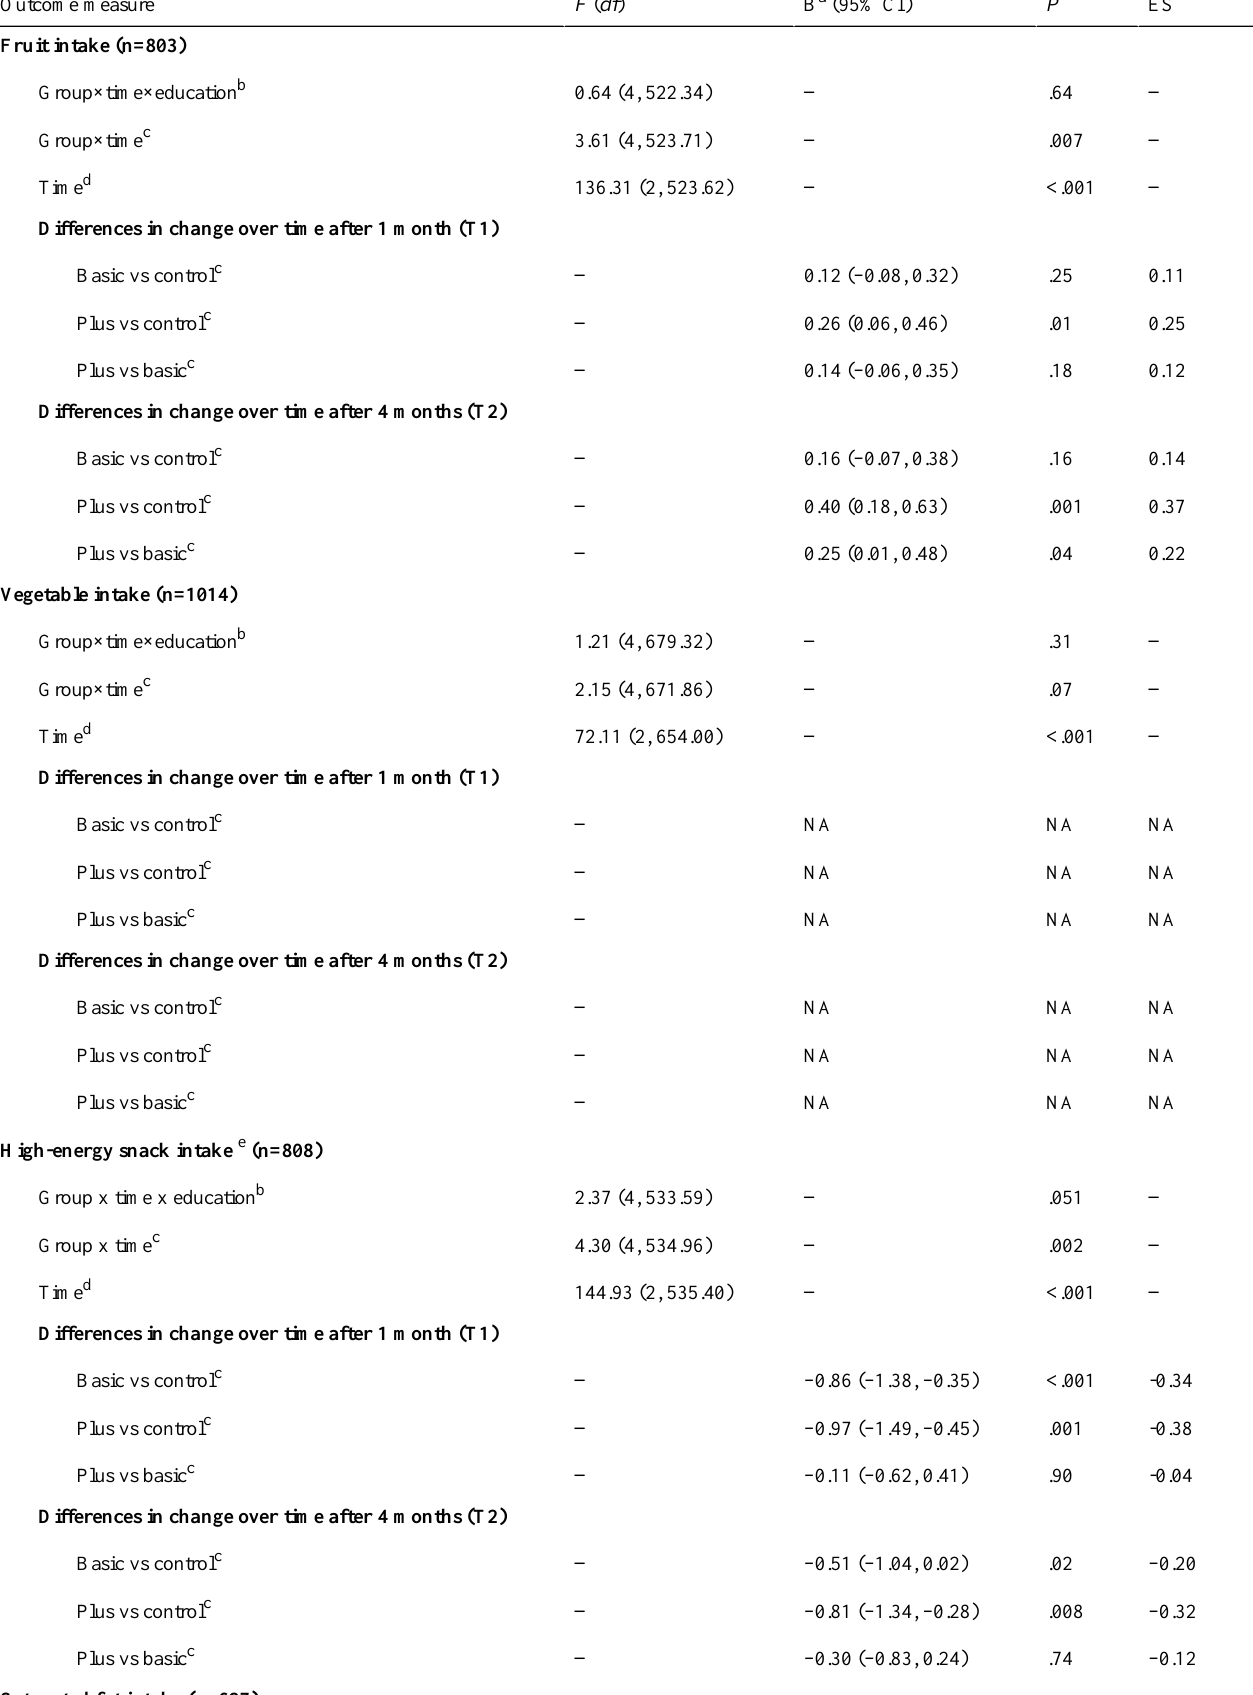
Table 5. Results of linear mixed model analyses for the risk